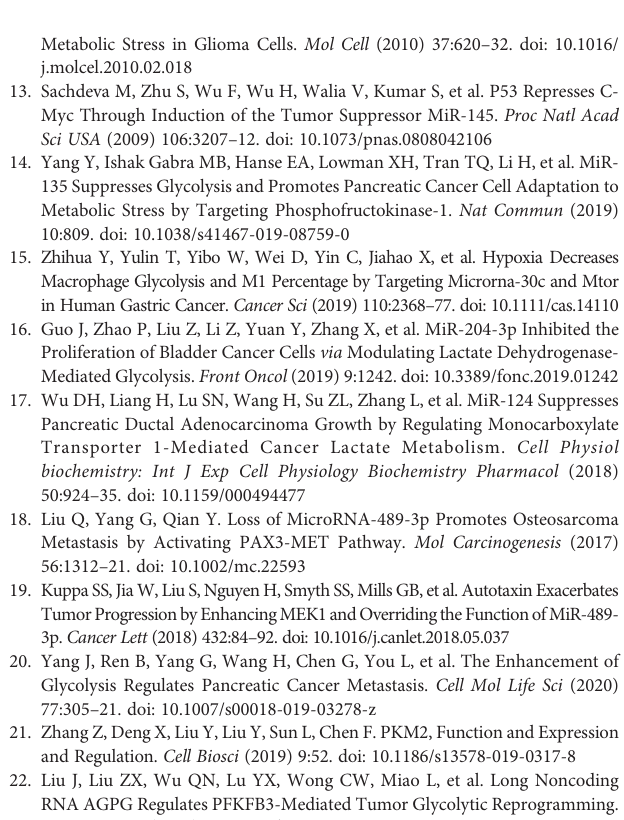
Supplementary Figure 1 | (A, B) Bioinformation analysis the miRNA and targets via the prediction database of STARBASE. Supplementary Figure 2 | LDHA and PKM2 restored the function of miRNA- mediatedproliferationandmetastasis ability. (A) q-RT-PCRshowedthattherelative expression of LDHA and PKM2 in PC cells transfected with miR-489-3p mimic, inhibitor, LDHA, PKM2 overexpressed plasmid or shRNA. (B, C) CCK8 and plate cloning and transwell migration assays showed that the proliferation ability of PC cells transfected with miR-489-3p inhibitor, LDHA, PKM2 shRNA. (D) Transwell assays show that the migration and invasionability ofPC cells transfected withmiR- 489-3p inhibitor, LDHA, PKM2 shRNA. (*P < 0.05, **P < 0.01, ***P,< 0.001,